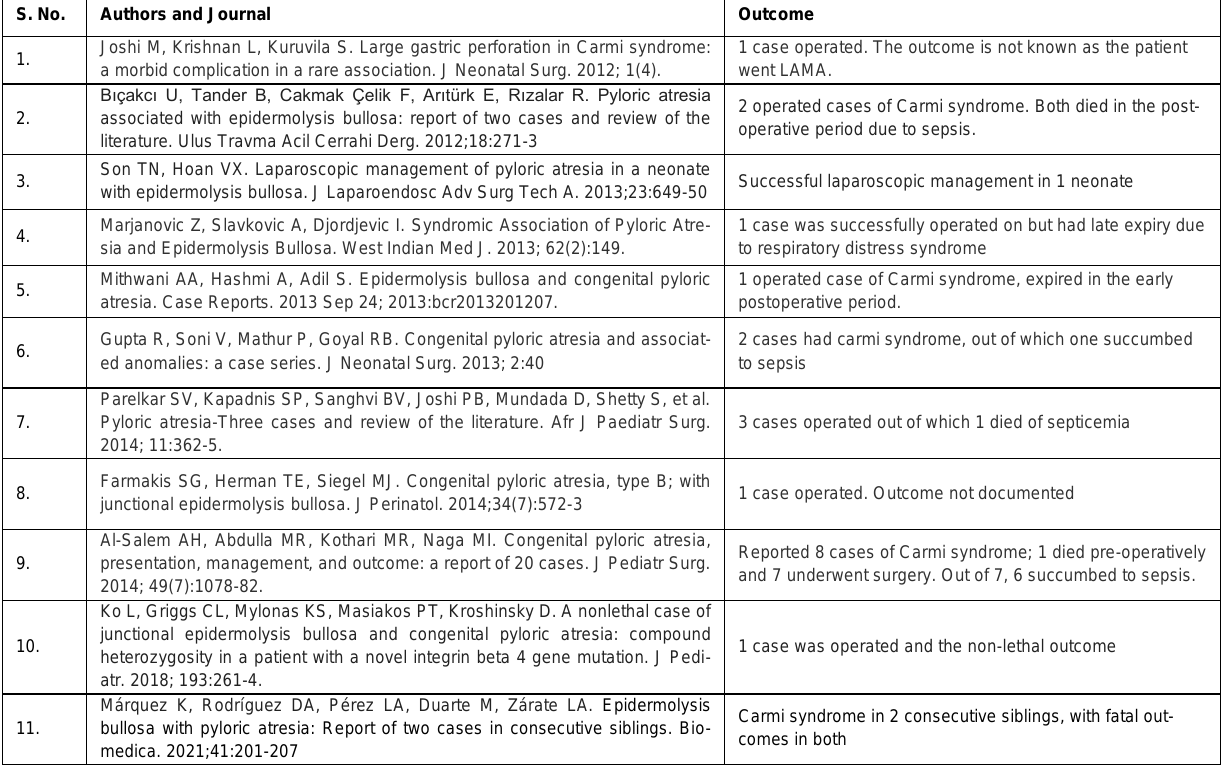
Table 2: A tabular presentation of Carmi syndrome cases reported in the literature from 2010 till